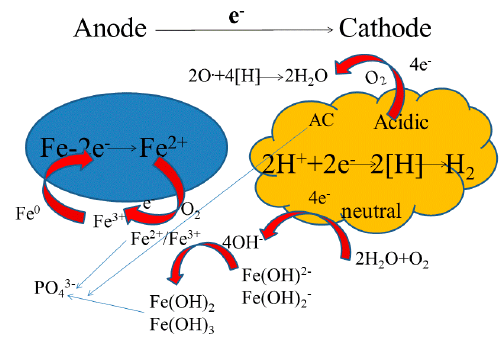
Figure 12. Mechanism of phosphorus removal by NICLS.